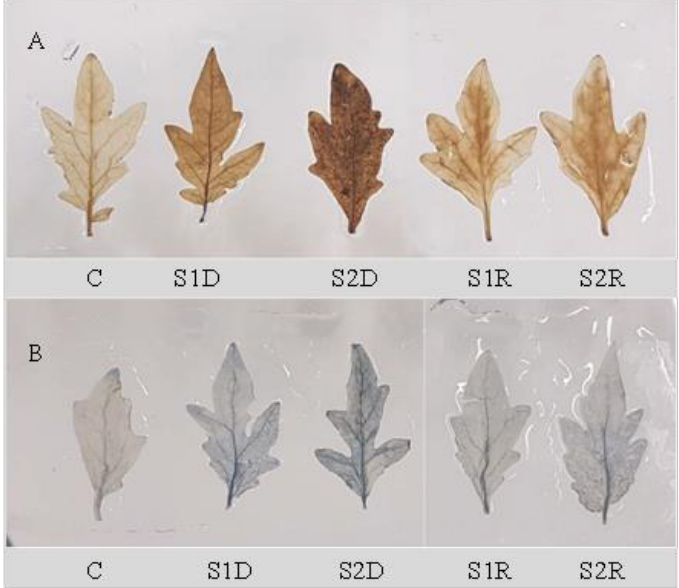
Figure 9. Histochemical detection of oxidative stress ( A , H 2 O 2 ; B, O 2 •− ) in tomato plants leaves under salinity (150 and 250 mM NaCl) and after a 48 h recovery period. Data means ( ± SD) were calculated from three replications. Statistically significant values are indicated by dissimilar letters (Fisher’s LSD test, P ≤ 0.05).